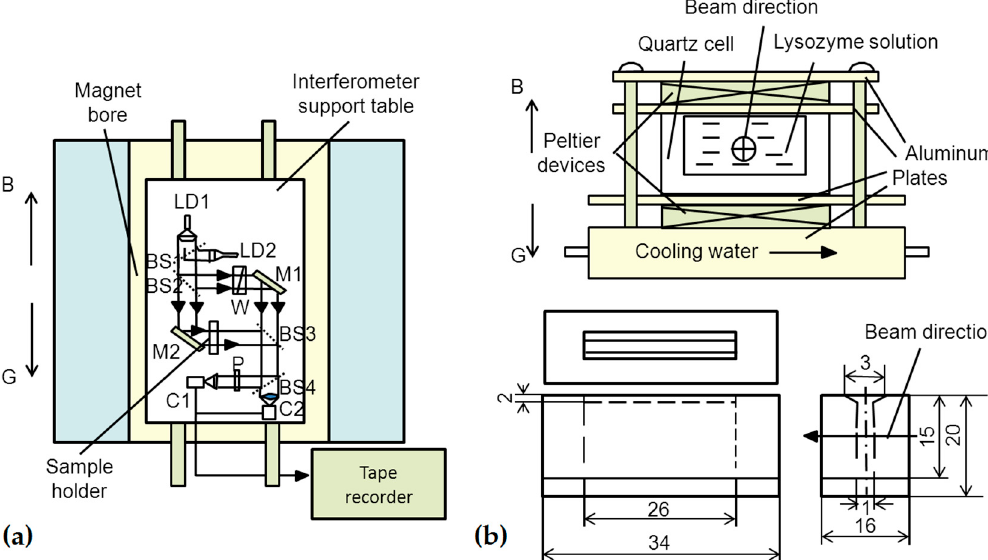
Figure 10. ( a ) Schematic drawing of the Mach–Zehnder interferometer in a superconducting magnet bore; and ( b ) sample holder and enlarged drawing of a sample cell [56]. Reproduced from reference [56] with permission from Elsevier and Copyright Clearance Center.